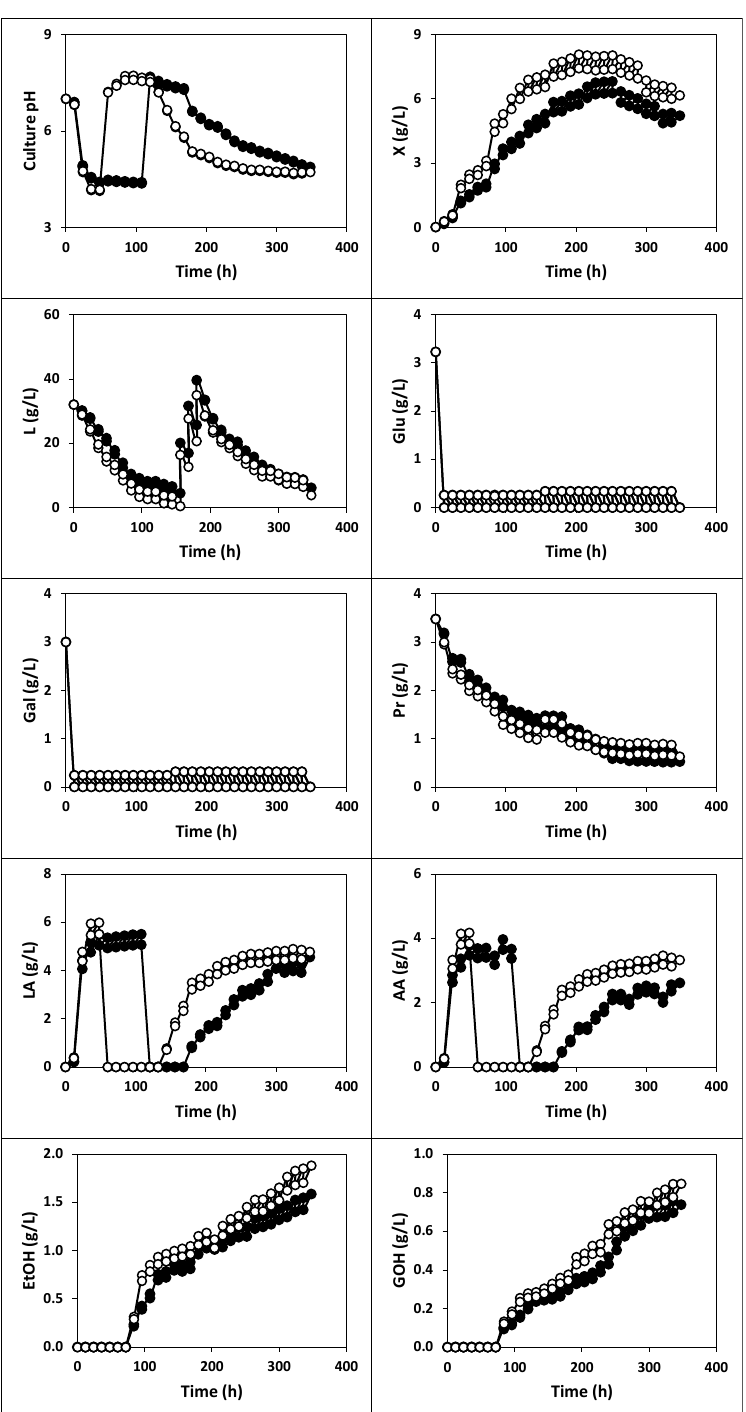
Figure 1. Fermentation kinetics (200 rpm) of whey with previously activated kefir grains AGK1 (1%, w / v ) and fermented whole milk (1%, v / v ) used in the activation ( white circles ), or with the previously activated kefir grains AGK1 (1%, w / v ) ( black symbols ). X: biomass, L: lactose, Glu: glucose, Gal: galactose, LA: lactic acid, AA: acetic acid, Pr: proteins, EtOH: ethanol, GOH: glycerol. The experimental data represent the means of two cultures carried out in parallel with two analytical replicates each.